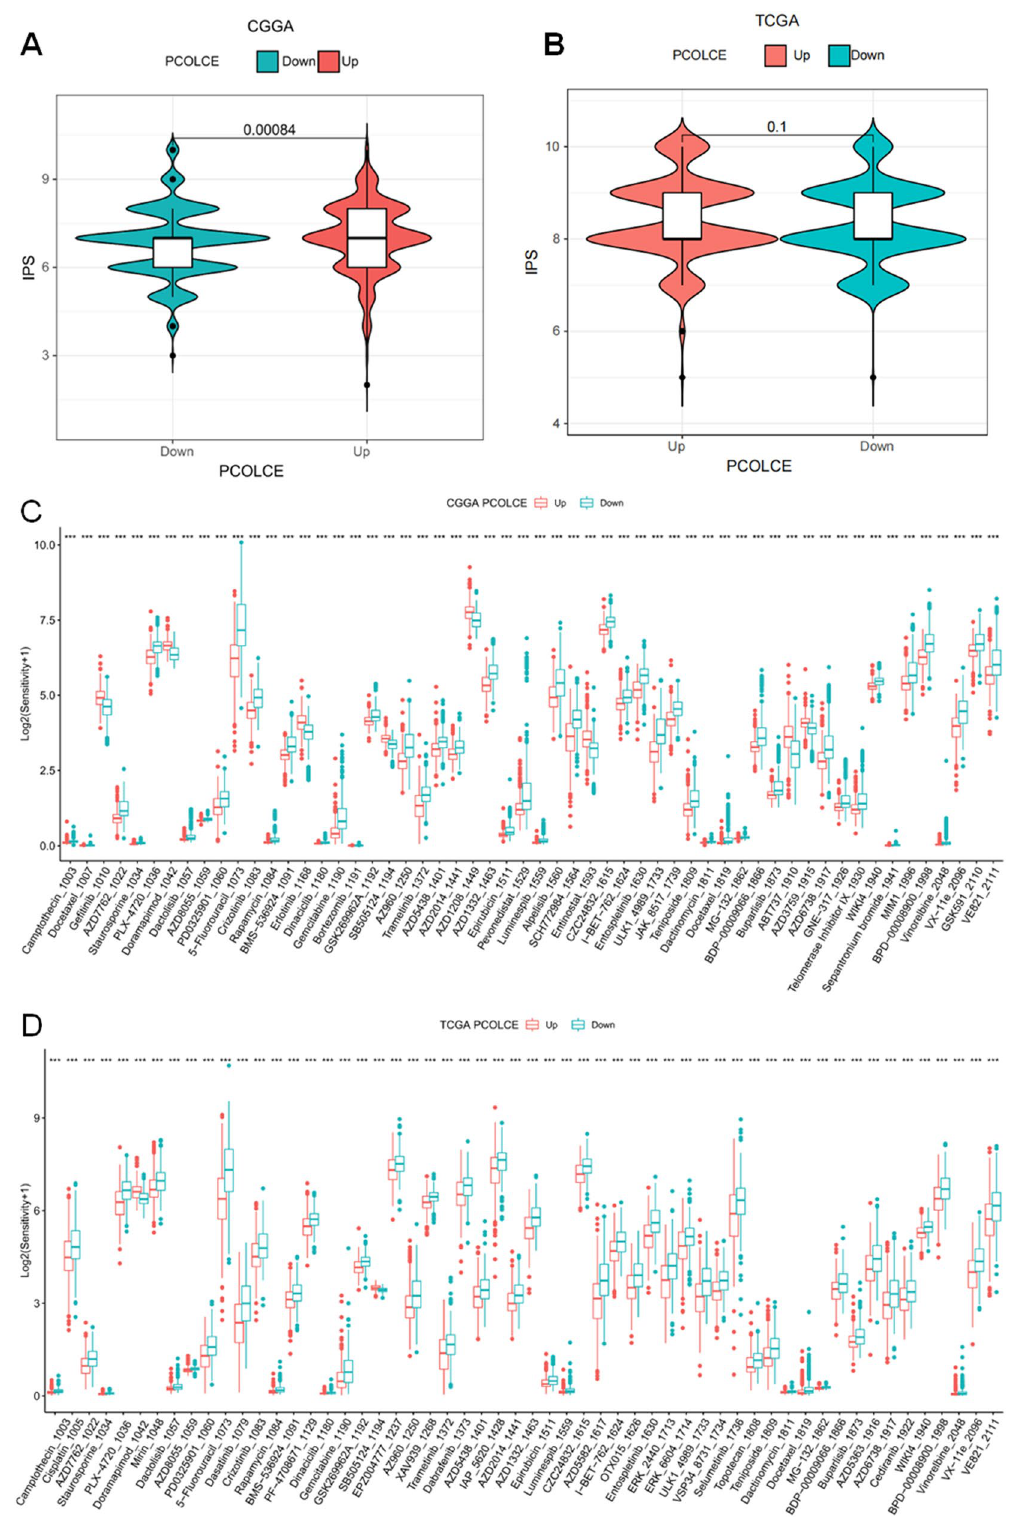
Figure 10. IPS score and drug sensitivity analysis of differential PCOLCE expression in CGGA and TCGA patients. ( A , B ) IPS score in the high and low PCOLCE expression groups. ( C , D ) Drug Sensitivity in the high and low PCOLCE expression